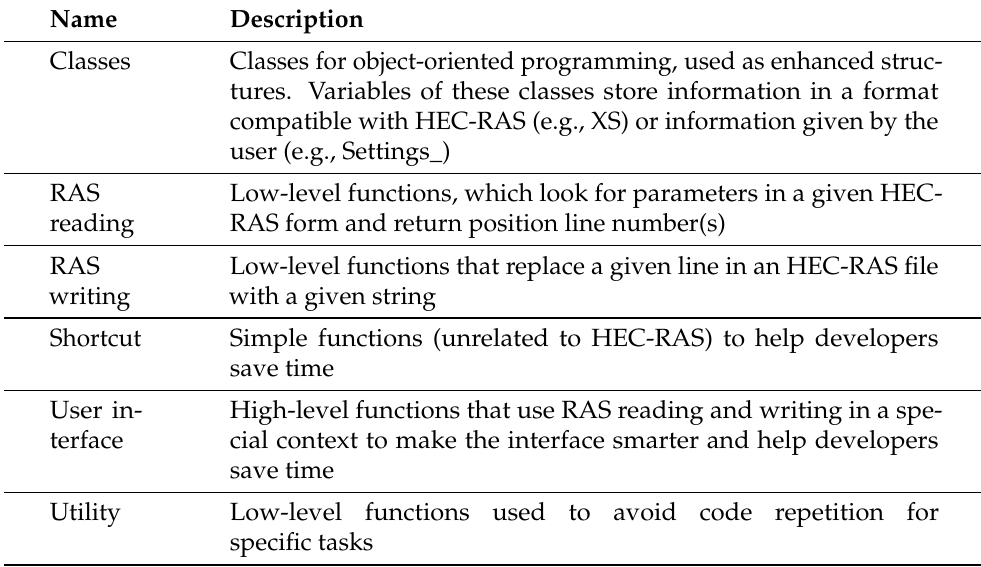
Figure 3. Screenshots of the directory tree of the MATLAB HEC-RAS interface code. Table 2. List of important